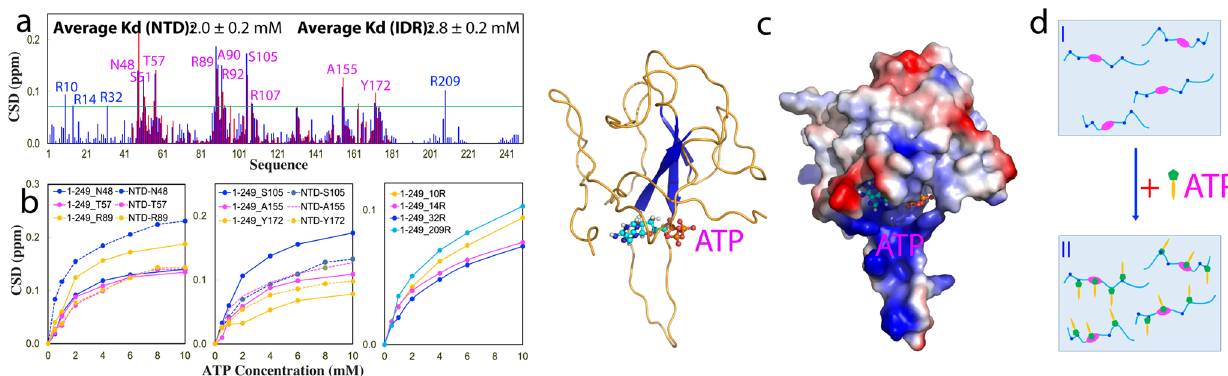
Fig. 2 Residue-speci fi c view of the ATP binding to NTD and IDR residues of N (1-249). a Residue-speci fi c chemical shift difference (CSD) of N (1-249) (blue) and isolated NTD (red) between the free state and in the presence of ATP 10 mM. The largely perturbed residues are de fi ned as those with the CSD values at 10 mM > 0.072 (average value + one standard deviation) (cyan line). b Shift tracings of HSQC peaks of six representative NTD residue in the context of N (1-249) and isolated NTD, as well as 4 Arg residues within IDRs in the presence of ATP at different concentrations. c The docking structure of the ATP-NTD complex we previously constructed for the isolated NTD. d Schematic representation of N (1-249) in the free state (I) and in the presence of the exceeding amounts of ATP